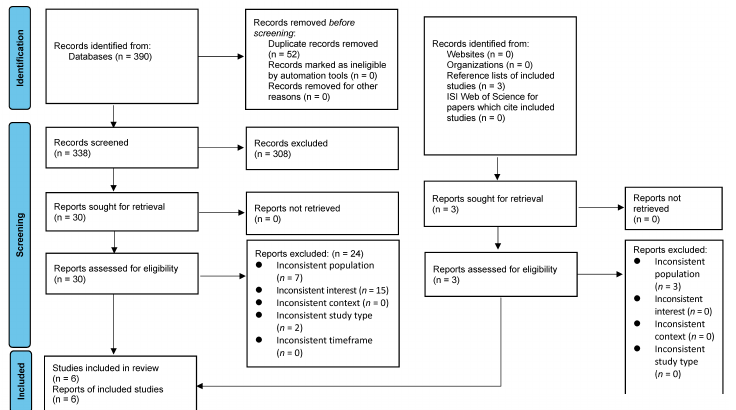
Figure 1. PRISMA flow diagram for search